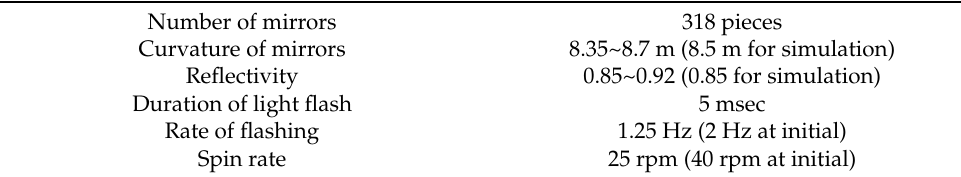
Table 1. Key parameters of Ajisai for TLTT